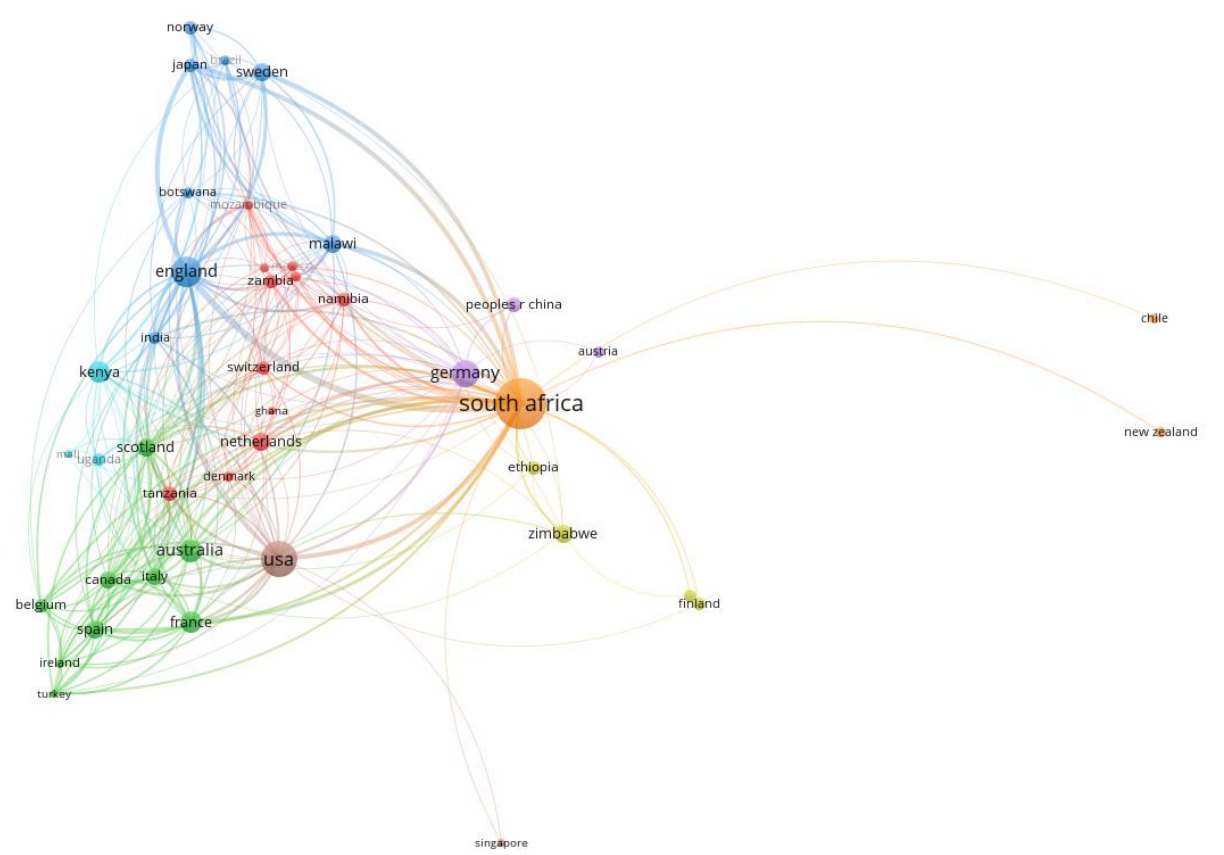
Figure 3. Co-authorship network of countries publishing on ESs from 1996 to 2021 . Table 2. Most co-operative publishing countries according to total link strength. Country Occurrences Links Total Link Strength South Africa